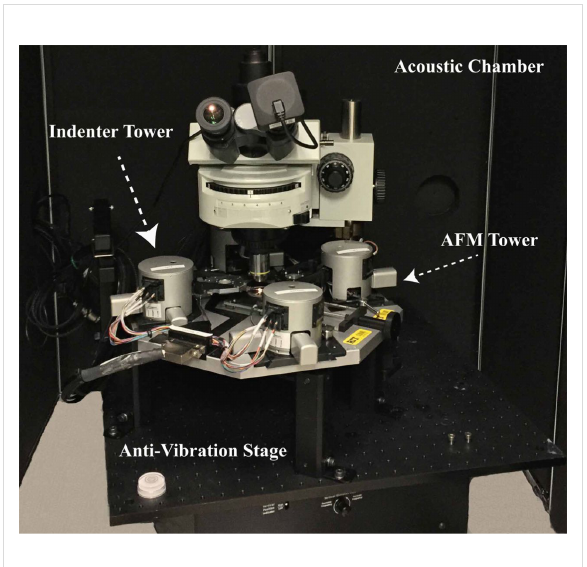
Figure 3: Positioning of the multi-probe system inside the acoustic